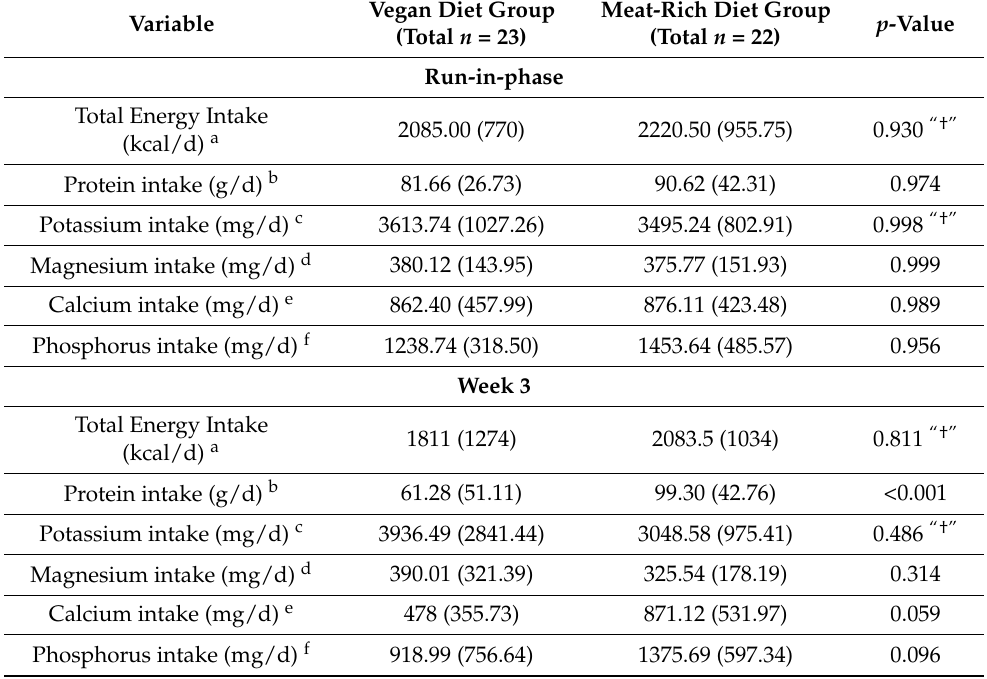
Table 2. Macro- and micronutrient intake during the run-in-phase and after 3 and 4 weeks across the vegan and the meat-rich diet group: A comparison. Normally distributed data are shown as mean ± standard deviation; not normally distributed data are shown as medians (interquartile range). p -values from post hoc tests for which Group × Time interactions were significant, except indicated by †. Number of participants used for statistical analysis after outlier removal: (a) vegan diet group, n = 22, meat-rich diet group, n = 21; (b) vegan diet group, n = 21, meat-rich diet group, n = 20; (c) vegan diet group, n = 21, meat-rich diet group, n = 20; (d) vegan diet group, n = 23, meat-rich diet group, n = 20; (e) vegan diet group, n = 22, meat-rich diet group, n = 21; (f) vegan diet group, n = 21, meat-rich diet group, n =